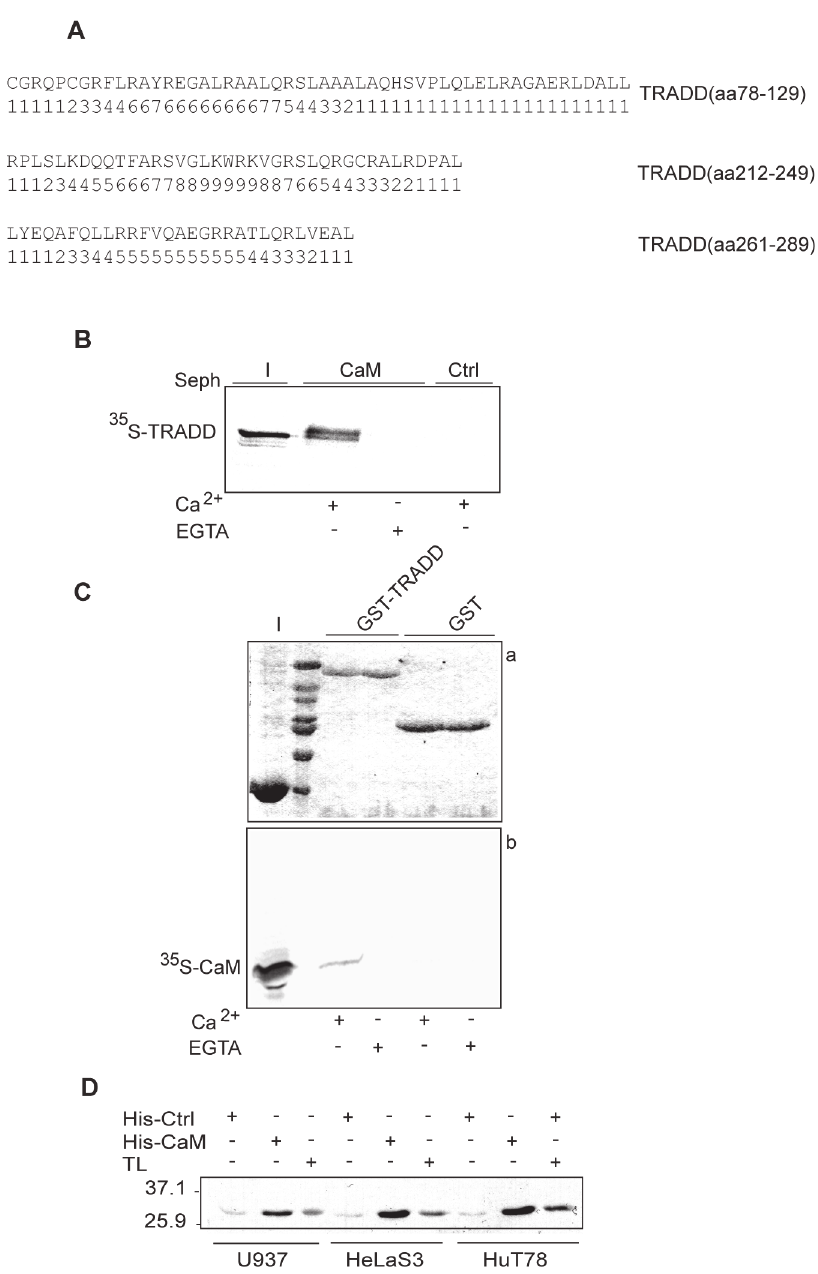
Figure 1. Ca 2+ -dependent binding of CaM to TRADD. A : CaM target database analysis. Amino acid sequences of the predicted CaM binding sites in human TRADD are shown along with the corresponding probability scores. B : autoradiography of CaM pull-down assay. (I) shows input of 35 S-TRADD ( * 33 kDa) incubated with CaM sepharose (CaM) or control sepharose (Ctrl) beads in Ca 2+ or EGTA binding buffer. C : autoradiography of pull-down assay of 35 S-CaM with GST or GST-TRADD. Panel a) shows a 12% SDS- PAGE stained with coomassie and panel b) the corresponding autoradiogram for 35 S-CaM. D : western blot of His-CaM pull-down assays. His-CaM or His-Ctrl (control, cyclophilin) bound to Ni-NTA agarose beads were incubated with cell lysates, as indicated. TL indicates total cell lysates. Positions of the molecular weight standards are indicated. The data shown are representative of at least three independent